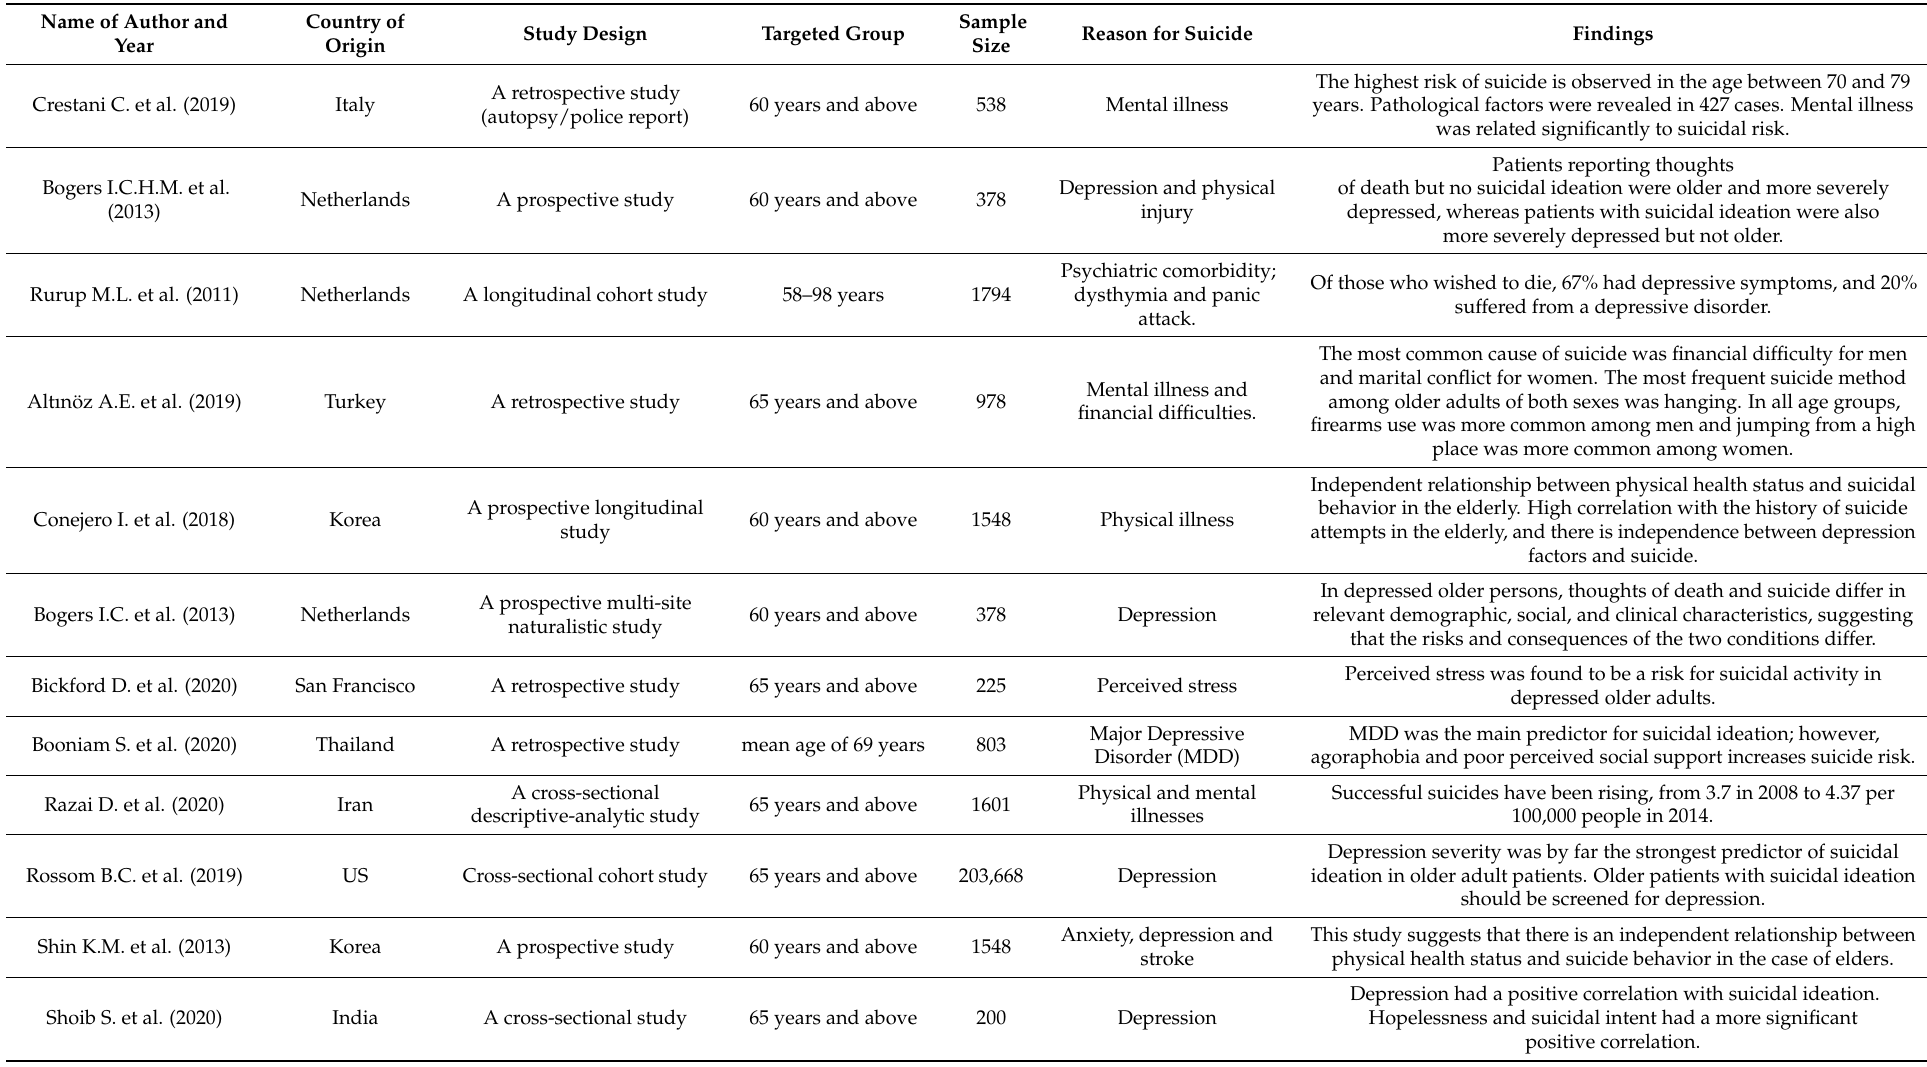
Table 2. Correlates of thoughts of death, suicidal behavior, and death by suicide in the